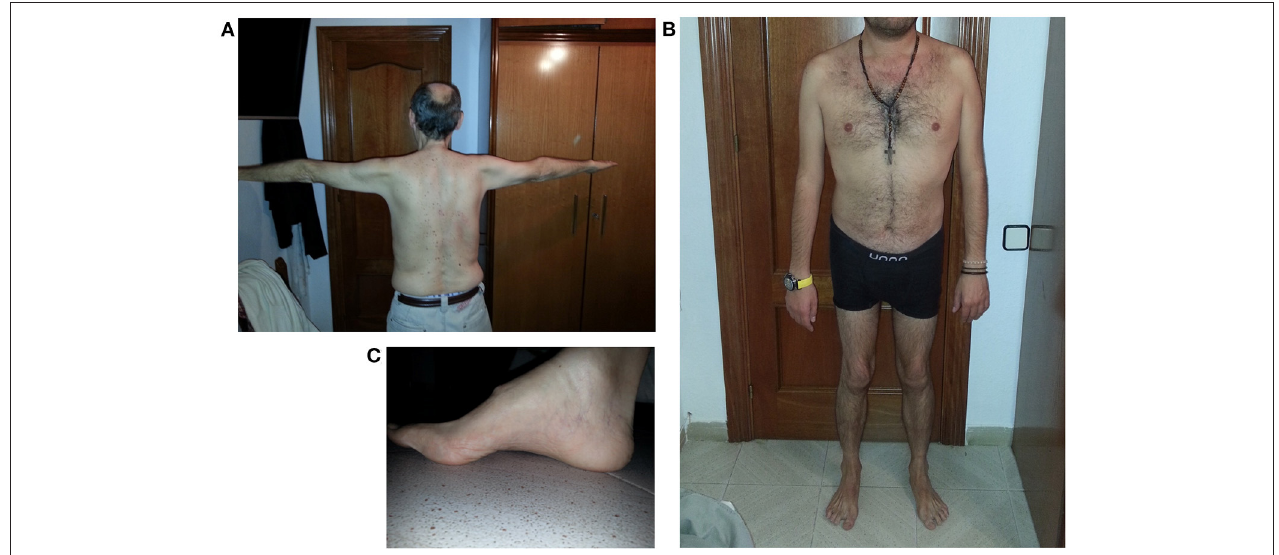
FIGURE 1 | Clinical features of LGMD D2 cases. (A) Atrophy of upper girdle muscles, especially deltoid and triceps brachii; (B) lower girdle muscle atrophy; (C) pes